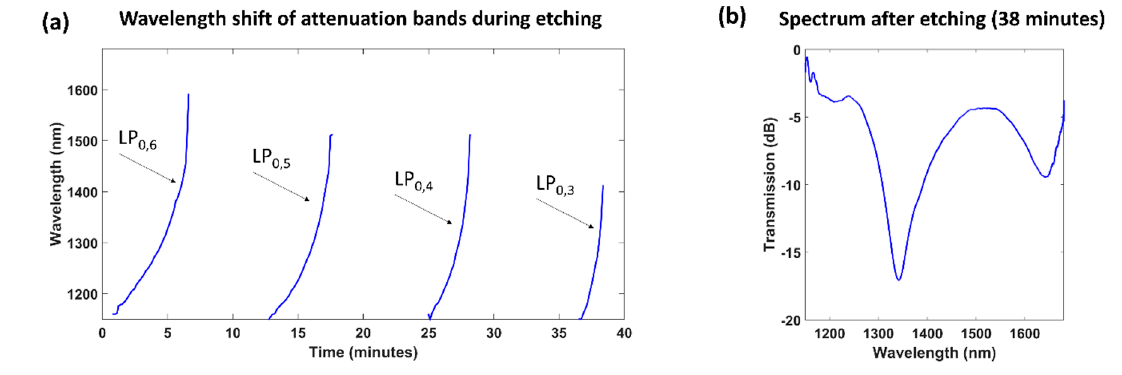
Figure 3. ( a ) Tracking of the attenuation bands in an LPFG with initial diameter 80 µm during etching process; ( b ) Spectrum corresponding with coupling to LP 0,3 (no spreading of the left and right attenuation band of the DTP is observed).